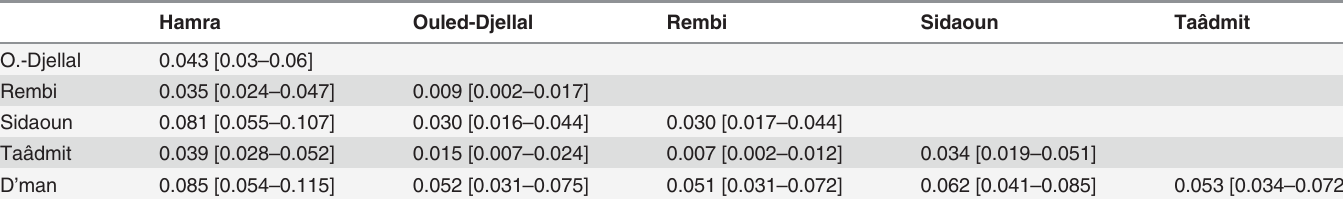
Table 2. Pair-wise F ST among Algerian breeds (with confidence intervals at 95%).